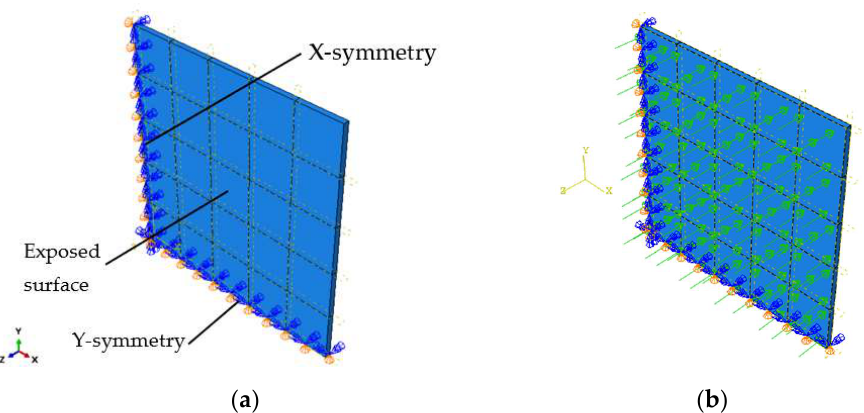
Figure 14. Finite element model: ( a ) mechanical boundary conditions; ( b ) heat flux applied at ex- posed surface (load symbols are not scaled according to the value).